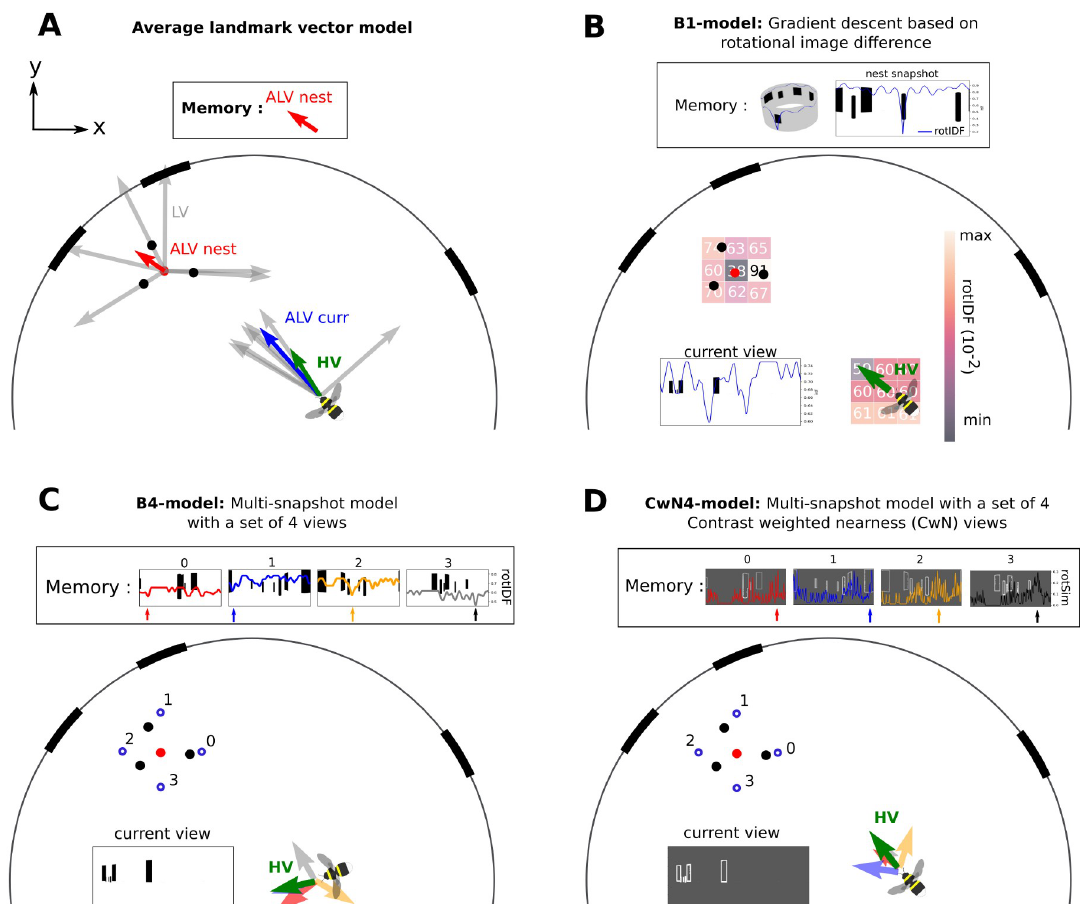
Fig 3. Schematic of the different tested models. A: Average landmark vector model, or ALV model: The stored vector in the memory is the ALV at the nest hole location (red arrow). The ALV at the nest is the average of each landmark vector (LV) at this location (grey arrows). The ALV at the current location is calculated in the same manner (blue arrow), and the ALV-nest is subtracted from this one. The resulting vector is the homing direction or Home Vector (HV) represented with a green arrow. B: the gradient descent model based on the image rotational difference function (rotIDF) of brigthness values will be termed B1-model; the minimum rotIDF is calculated at each grid position, the potential obtain is plotted on a downsampled grid and a colourmap (from black to white), indicating the value of the minimum rotIDF. The agent will descent the potential, thus, moving in the direction of the darkest neighbouring point on the represented grid. The rotIDF is overlaid with the current view by a blue line. The nest snapshot stored in memory shows a null minimum in the rotIDF at the middle of the image for 0˚ orientation. Important: the value of the minimum rotIDF at the current location is the only information used to create the potential. Finally, the minimum rotIDF values on the represented coloured grid is not null at the nest due to the downsampling of the grid for illustration purposes, the grid is not falling below the exact nest location where the minimum rotIDF is indeed null. C: The multi-snapshot model or Bn-model. In this example, 4 views constituting a set of views are taken outside of the cylinder constellation on a 15 cm radius circle (B4-model). Each view is overlaid by its rotIDF function with the current view. Each view refers to a heading direction of the same colour (red, blue, yellow and grey). The green arrow represents the weighted circular average of all headings, it is the HV. D: The multi-snapshot model based on contrast weighted nearness (CwN) views, or CwNn-model. 4 CwN snapshots at 15 cm from the nest are taken (CwN4-model). Each view is overlaid by its similarity function with the current view, leading to different heading directions at the current position (coloured arrows). The weighted circular mean of the different headings is the green arrow indicating the HV direction.